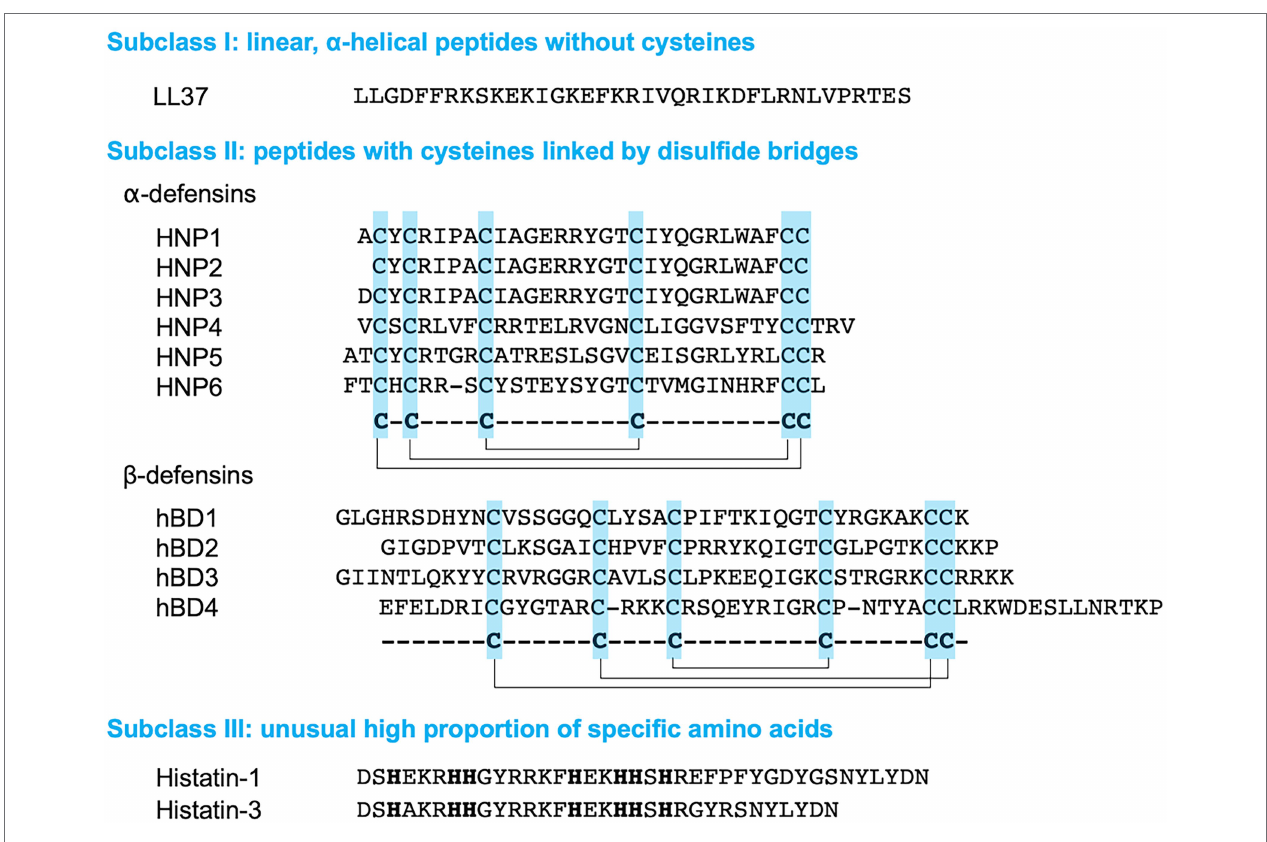
FIGURE 2 | Amino acid sequences of human antimicrobial peptides (AMPs). The disulfide bonds in α - and β -defensins are indicated by solid lines. The histamine residues in Histatin-1 and -3 are indicated by bold